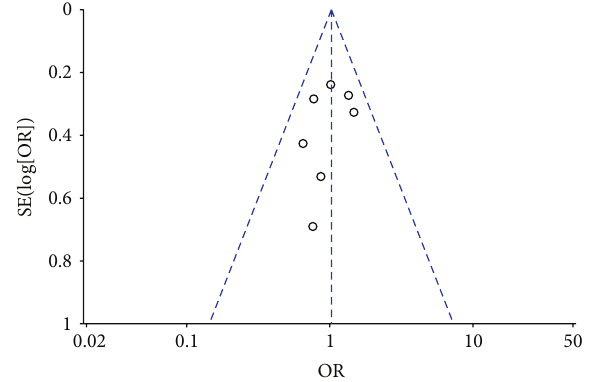
Figure 3: Funnel plot of the outcome of anastomotic leakage. OR, odds ratio; SE, standard